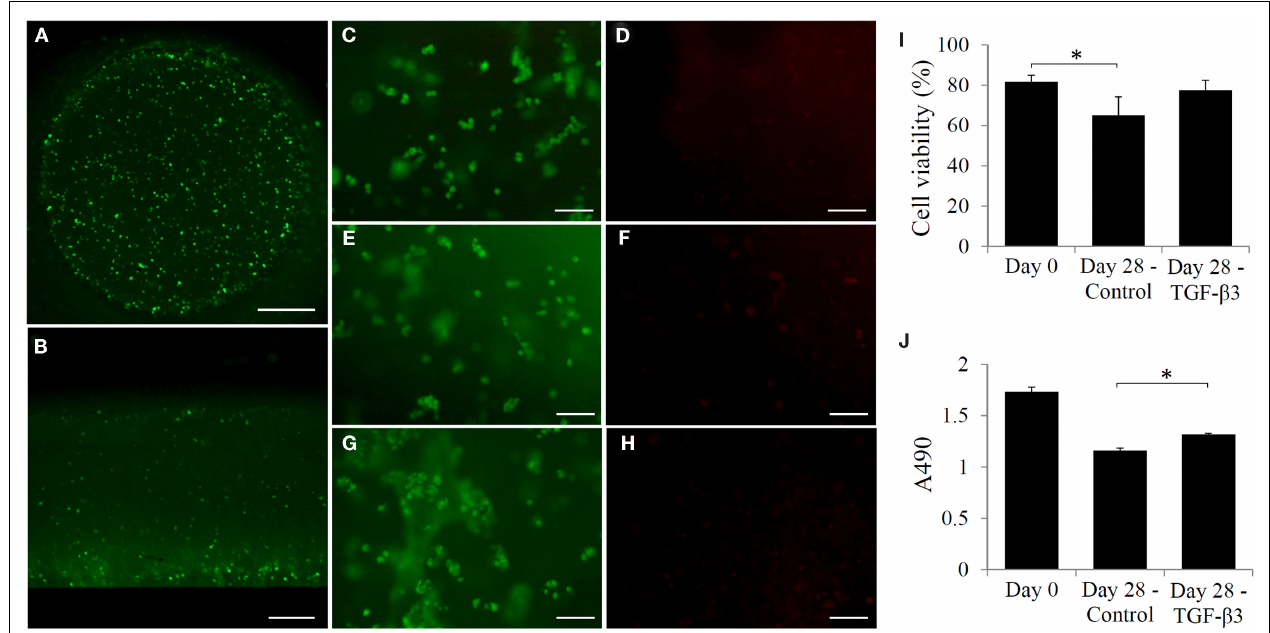
FIGURE 3 | Cell viability in VL-PSL generated mPDLLA-PEG scaffolds at 0 and 28days after fabrication . (A–C,E,G) Calcein-AM staining (green, live cells) and (D,F,H) EthD-1 staining (red, dead cells) in scaffold demonstrate the cell viability following fabrication throughout VL-PSL method. Cells were seen to